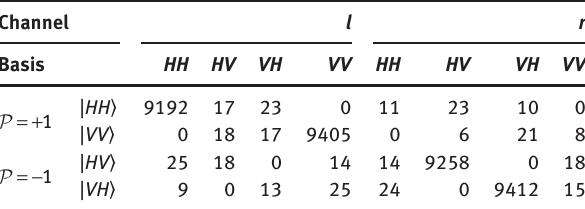
Table 1: Coincidence counts for parity checks.